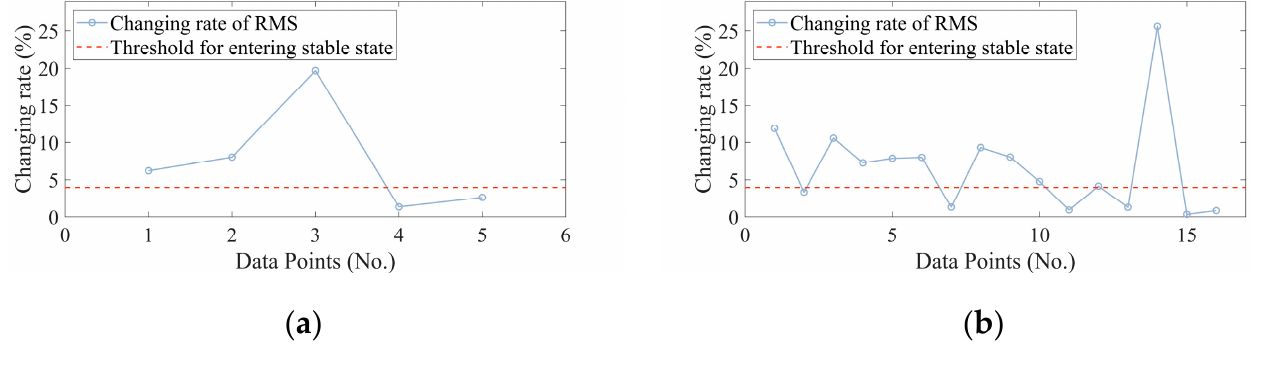
Figure 15. Changing rates of RMS: ( a ) Dataset 1, ( b ) Dataset 2. Table 8. Results of OHS selection.